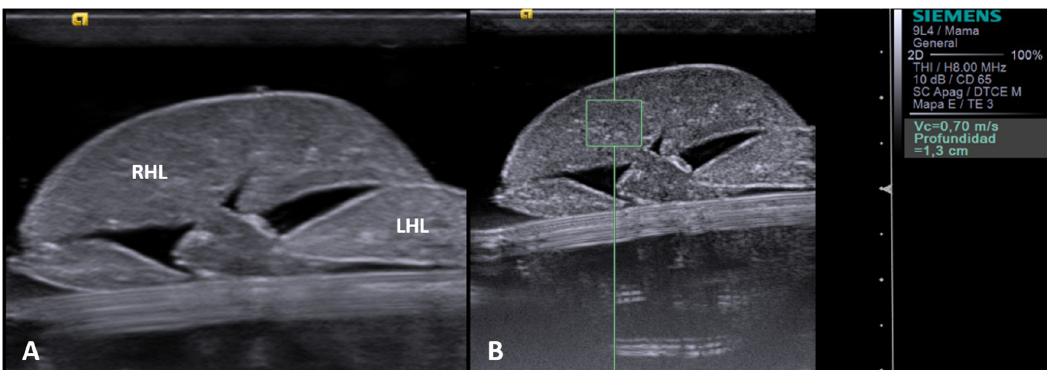
Fig 3. A , Ex vivo ultrasound image of the liver explant. RHL: right hepatic lobe; LHL: left hepatic lobe. B , Ex vivo assessment using ARFI.